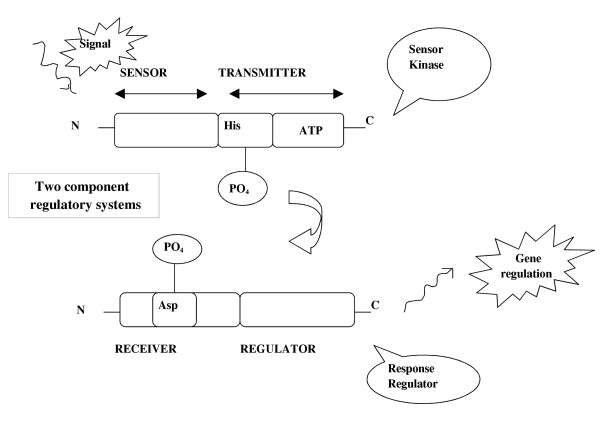
Two Component Regulatory Systems. The first component, sensor kinase autophosphorylates and transfers phosphate to the response regulator. These are also called the HAP systems indicating the involvement of Histidine of sensor kinase and Aspartate of Response regulators playing a key role in signal transduction.